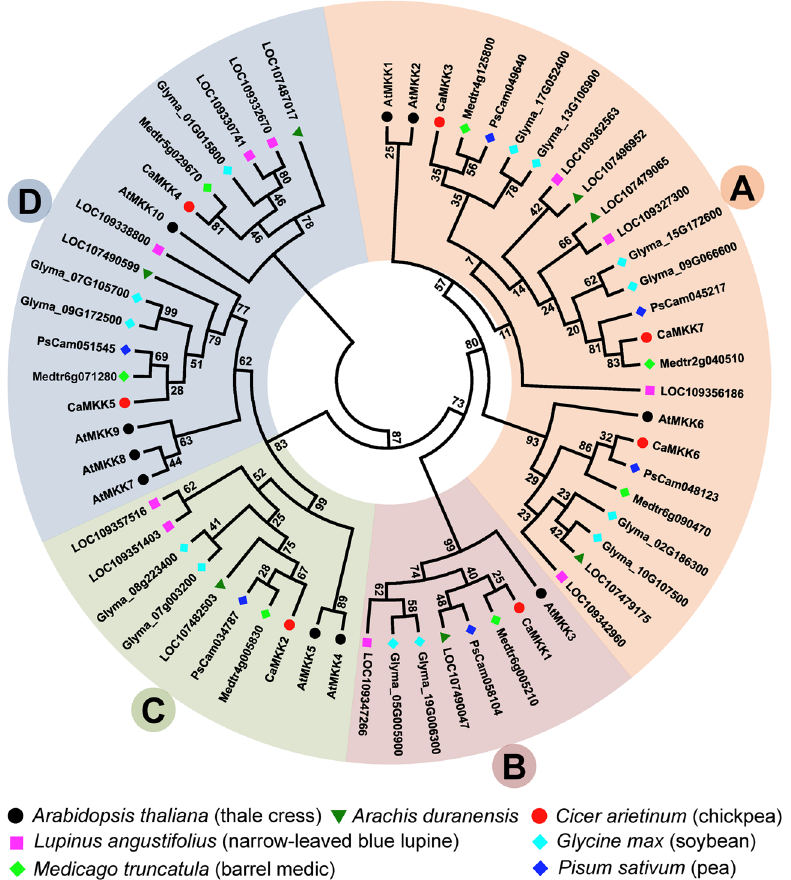
Figure 1. Maximum likelihood phylogeny of MKKs from six legumes and Arabidopsis. The MKKs are divided into four groups A–D. The names of the genes are indicated against deep branches. The protein sequence alignment was performed on PROMALS3D server and phylogeny was constructed using MEGA7.0.21. Phylogeny was validated by bootstrap values that were derived from 1000 iterations. A detailed phylogenetic relationship within MKKs of 16 legume species and default parameters of MEGA7.0.21 are illustrated in Supplementary Table